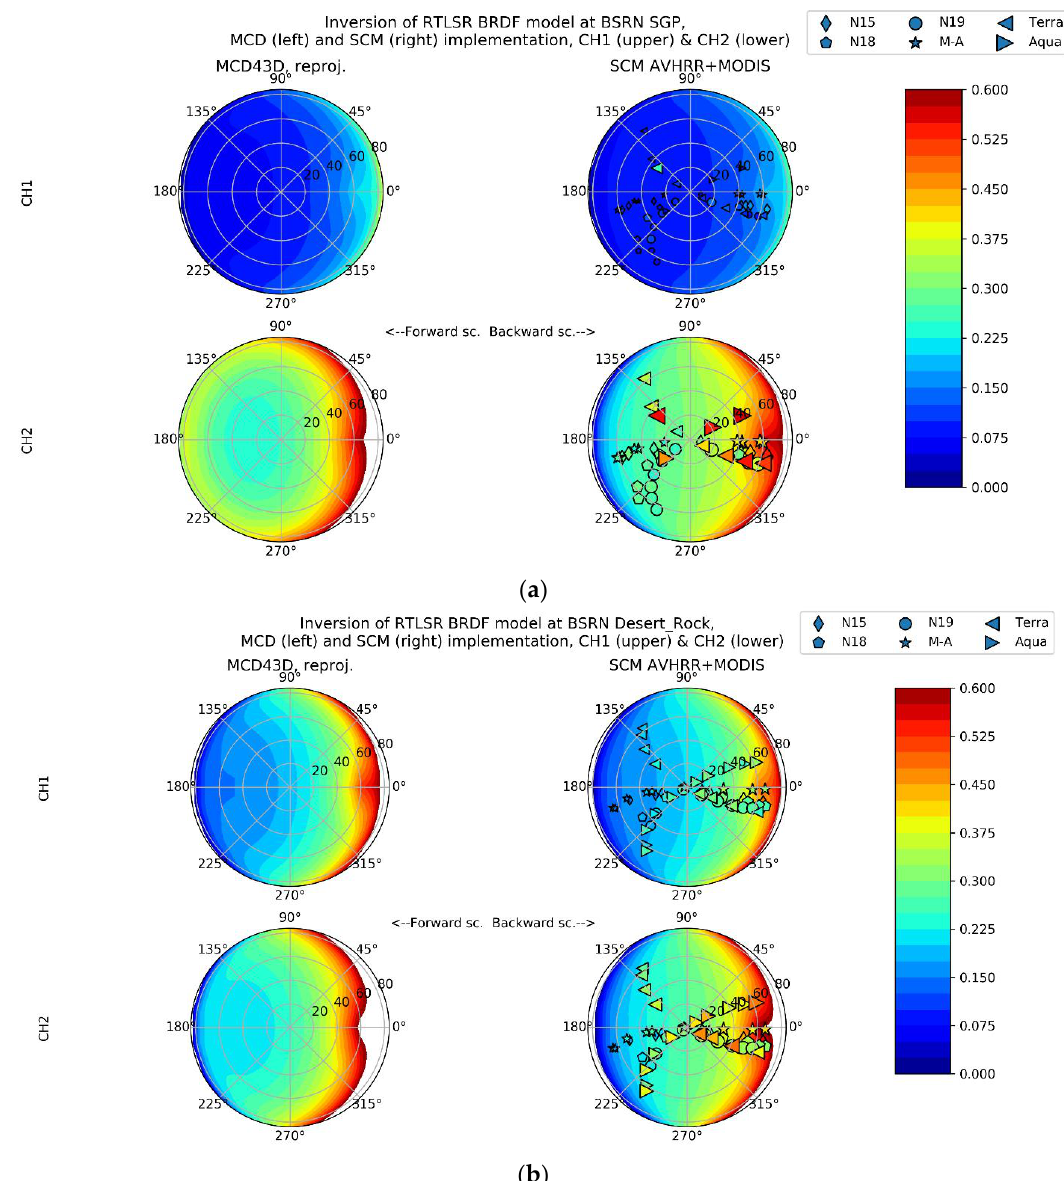
Figure 8. The illustration of the RossThick-LiSparse-Reciprocal BRDF model inversion and resulting reflectance hemisphere for MCD43D reprojected to the SCM grid ( left ) in comparison with SCM data ( right ) at the ( a ) SGP site and ( b ) Desert Rock site. The data shown for DOY 190 – 200, with MODIS data from DOY 195. The upper polar plots show the inversion for CH1 and the lower for CH2. The MCD43D reflectances are shown for MODIS bands, the SCM reflectances for AVHRR bands. The radial distance indicates the increasing θ v and azimuthal angles indicate azimuth from the solar direction (here at the azimuth of 0°, at a θ s of 60°). Forward scattering directions located to the left of plot origin, the backward scattering directions to the right. The markers overlaid in the SCM reflectance hemisphere indicate individual valid AVHRR and homogenized MODIS surface reflectance observations used in the inversion. The marker type identifies each satellite individually and the size increases with increasing reflectance. Surface reflectances above 0.6 are not shown to preserve color resolution. ‘M - A’ Refers to Metop -A in the legend.